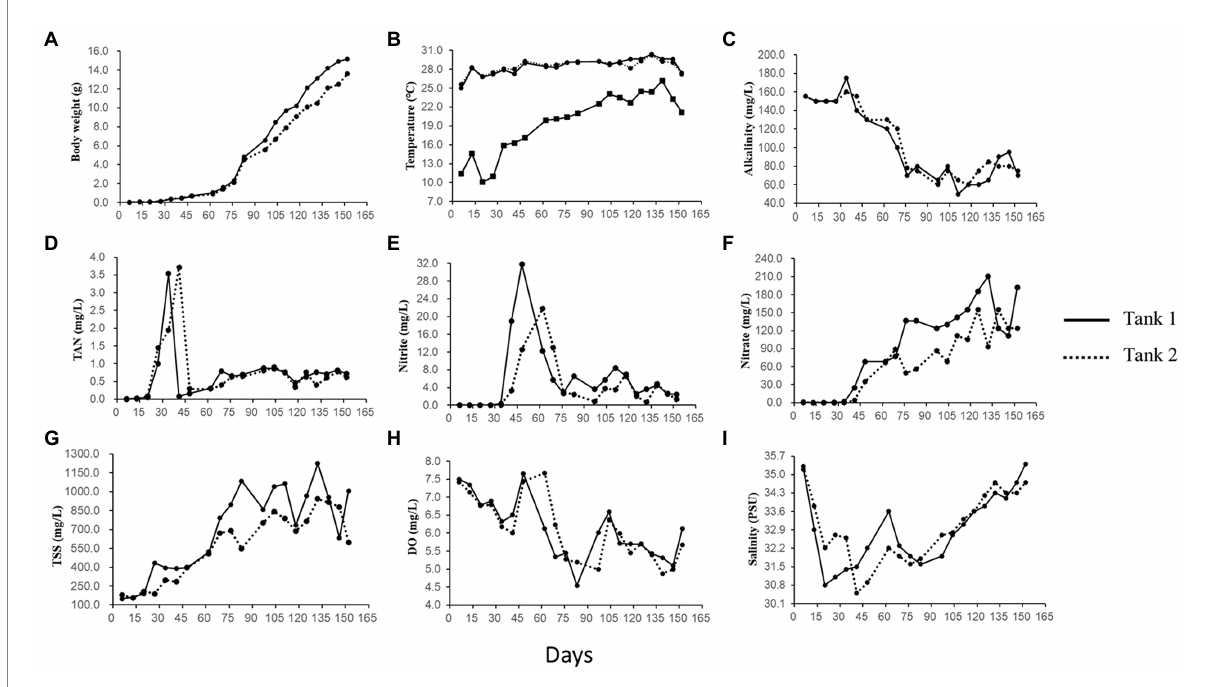
FIGURE 1 Body weight of the reared Litopenaeus vannamei and physicochemical parameters of rearing water over 152 growth days in a biofloc aquaculture system. Curves show values of (A) body weight, (B) temperature of rearing water (upper curves) and air (lower curves), (C) alkalinity, (D) total ammonia nitrogen (TAN), (E) nitrite (NO 2 -N), (F) nitrate (NO 3 -N), (G) total suspended solids (TSS), (H) dissolved oxygen (DO), and (I) salinity in culture Tank-1 and -2.